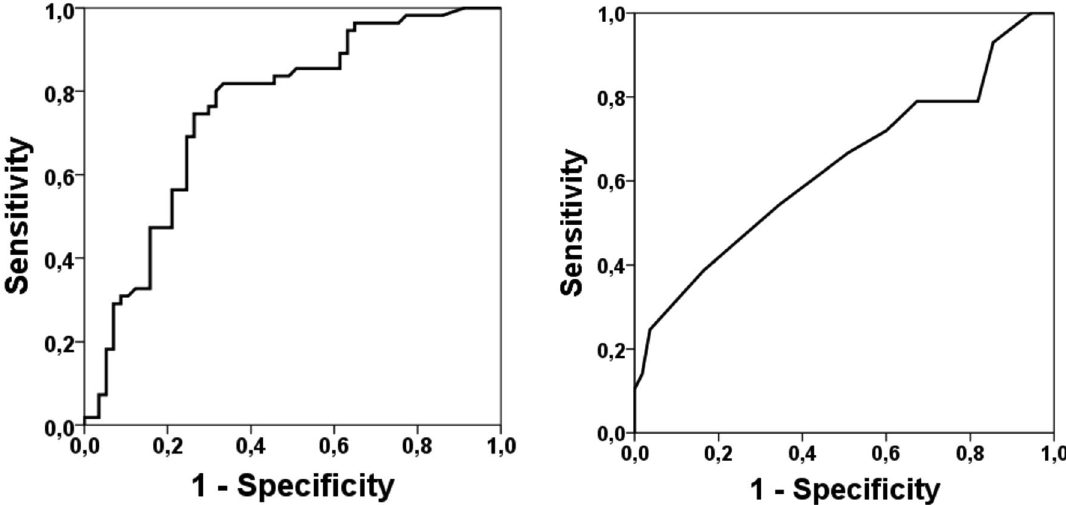
Figure 3. Comparison of ROC curves for Energy (left) and SOFA scale (right). ROC curves demonstrate the ability of Energy (SDNN) to discriminate the mortality with an AUC = 0.755 at an Energy threshold of 0.31 s (sensitivity 71.9%, specificity 74.5%, a positive predictive value 74.5%, predictive negative value 71.9%) compared with the ability of SOFA scale to discriminate the mortality with an AUC = 0.636. AUC, area under the